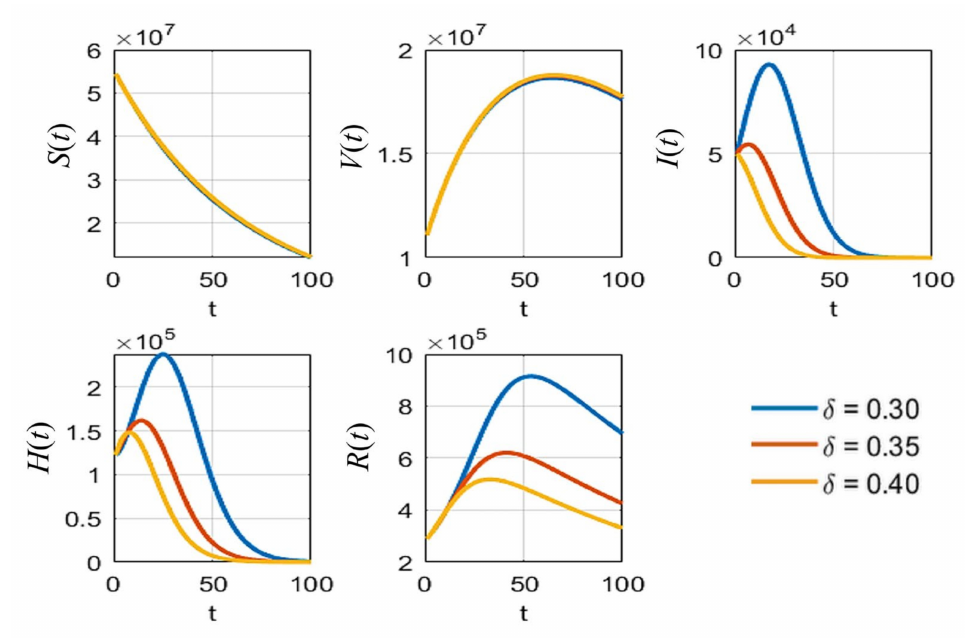
Figure 6. The simulation results of all populations compared with different rates of detection ( δ ) .